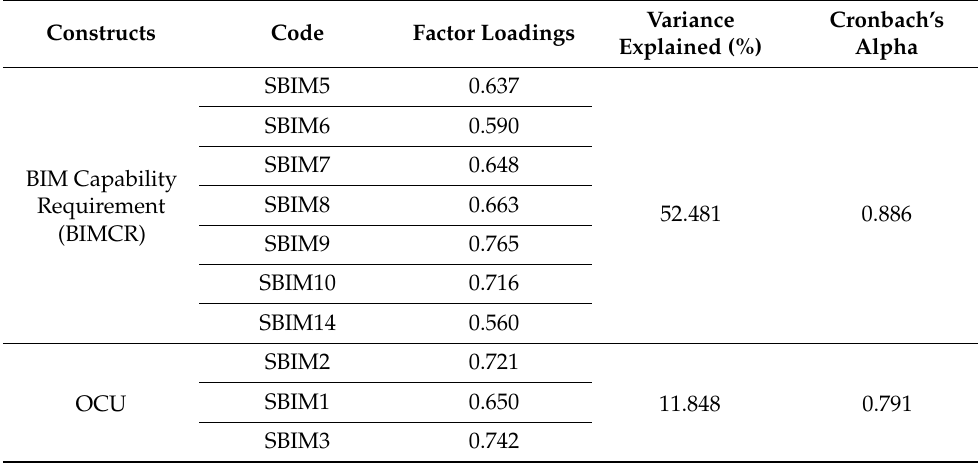
Table 4. Results of FA on strategies for improving